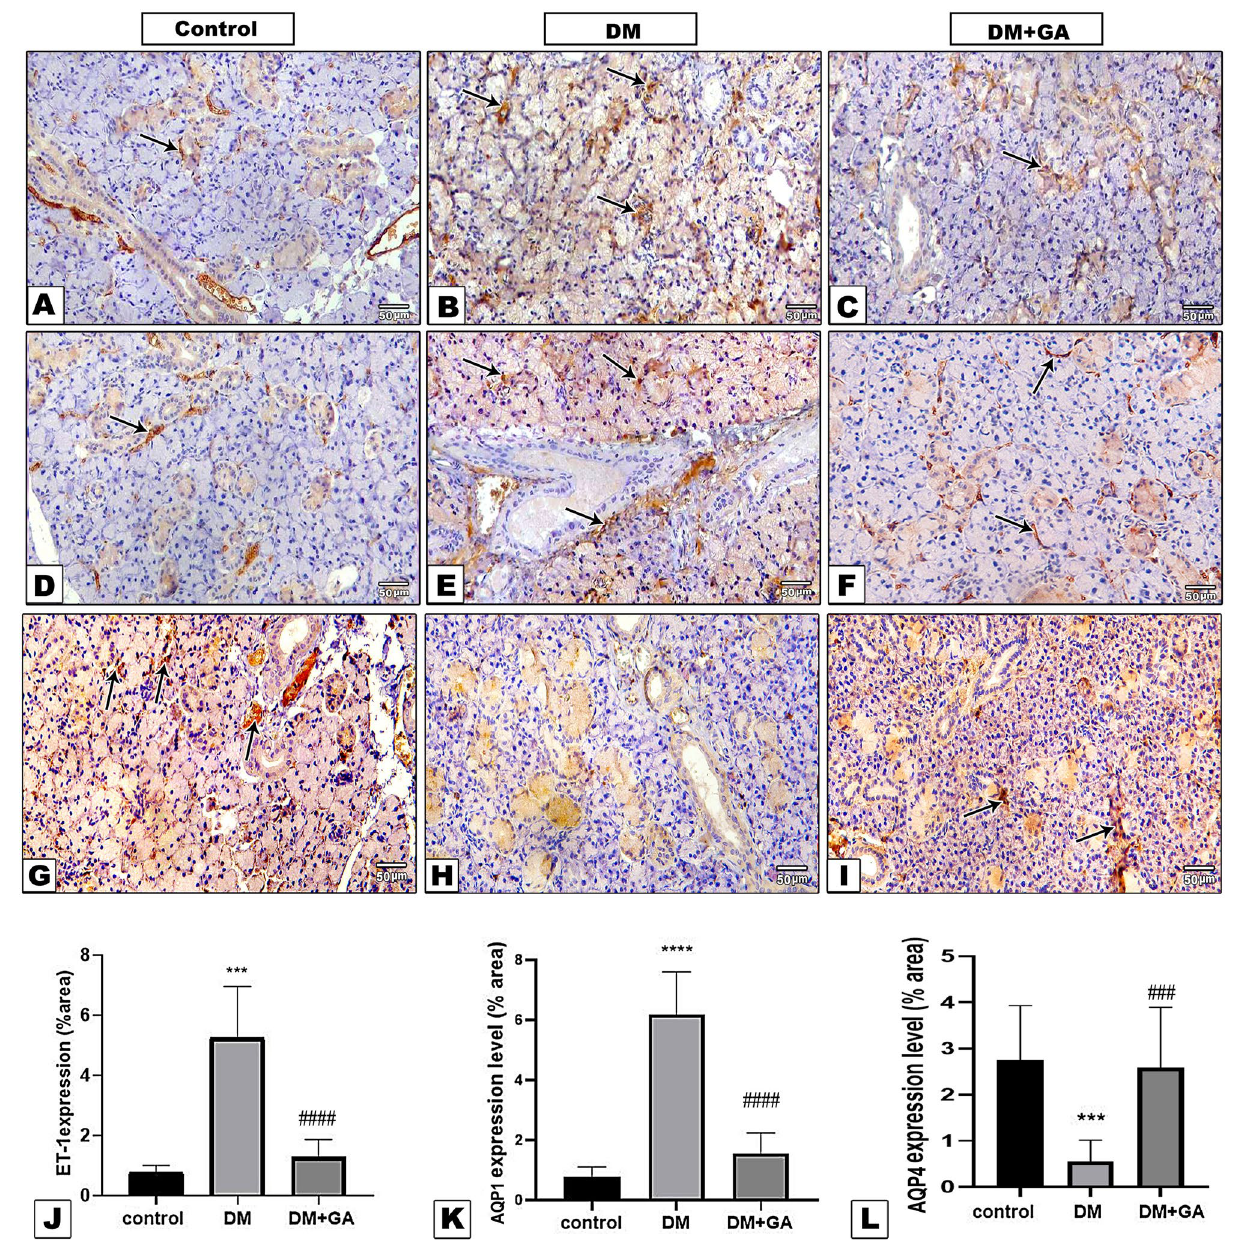
Figure 5. ET1 immunostained sections of SMG shows positive brown reaction around interlobular ducts and blood vessels in control group ( A ), DM group shows mucous changes in the acini with marked expression of ET1 in vascular and acinar components of the parenchyma ( B ). GA application reduced ET-1 expression ( C ). AQP1 immunoreaction was localized in the parenchymal vasculature of SMG in control group ( D ) and GA treated group ( F ), while this reaction was markedly increased in DM group ( E ). GA restored AQP4 expression levels in diabetic SMG tissue ( I ) where diabetic group showed a marked reduction in AQP4 expression ( H ) compared to the control group ( G ). (ET-1, AQP1, AQP4 IHC, × 20). Quantitative analysis of immunostaining %area of ET-1 ( J ), AQP1 ( K ) and AQP4 ( L ). Data were expressed in mean ± SE. P < 0.05 is considered